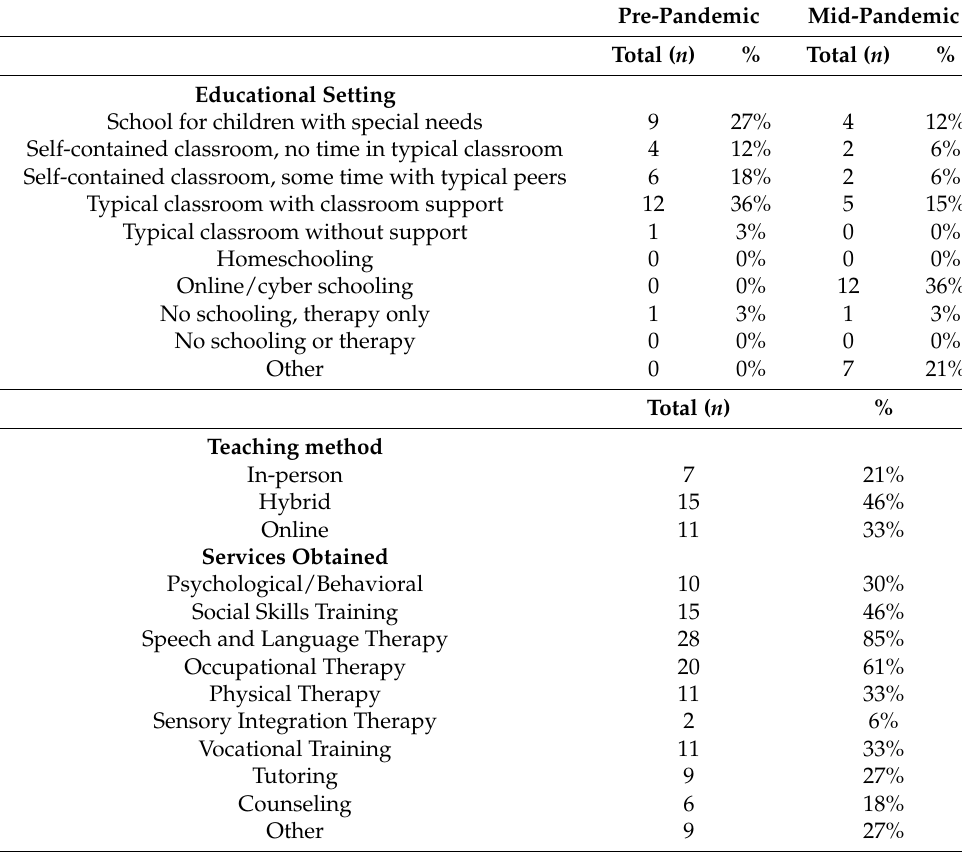
Table 2. Education and services